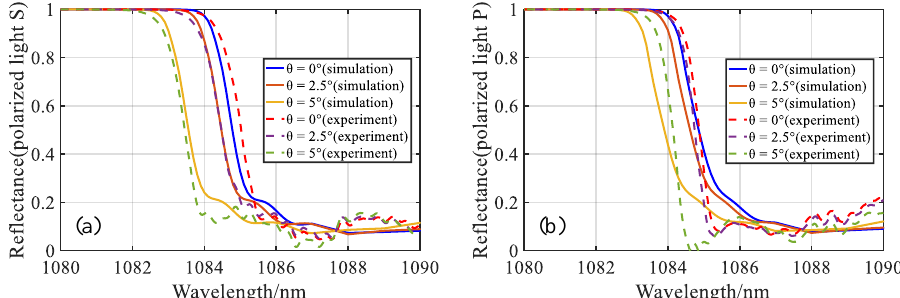
Figure 6. The simulation and experimental results of the reflectance curves under different incident angles: ( a ) s polarization; ( b ) p polarization.